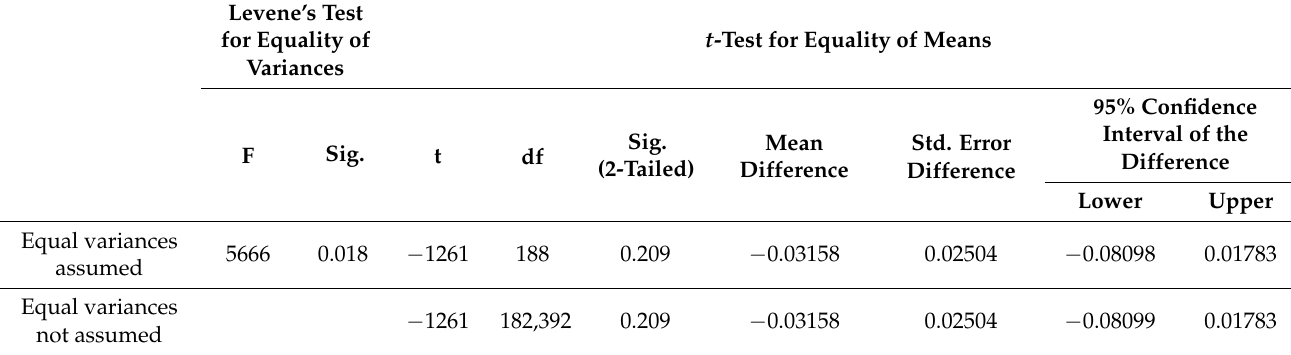
Table 5. A comparison of experimental group learners’ content knowledge in the pre-and post-tests. The table shows the comparison of scores obtained by learners who participated in the recycling